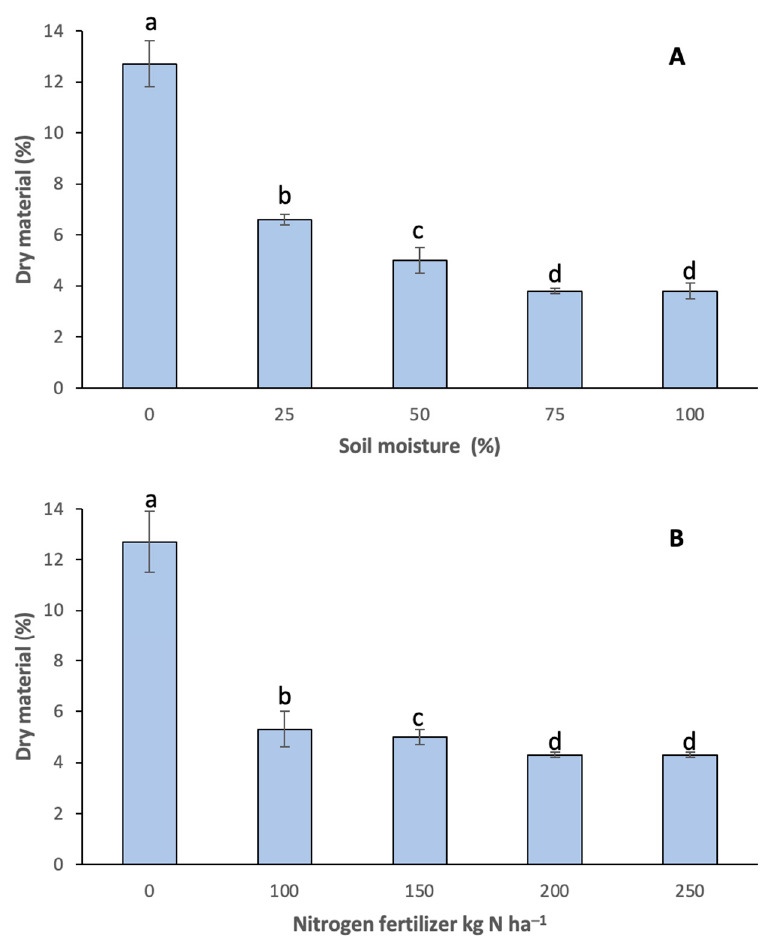
Figure 2. Onion dry matter at different ( A ) soil moistures and ( B ) nitrogen fertilization. Different letters indicate significant difference ( p < 0.05). Media ± standard deviation of three repetitions.